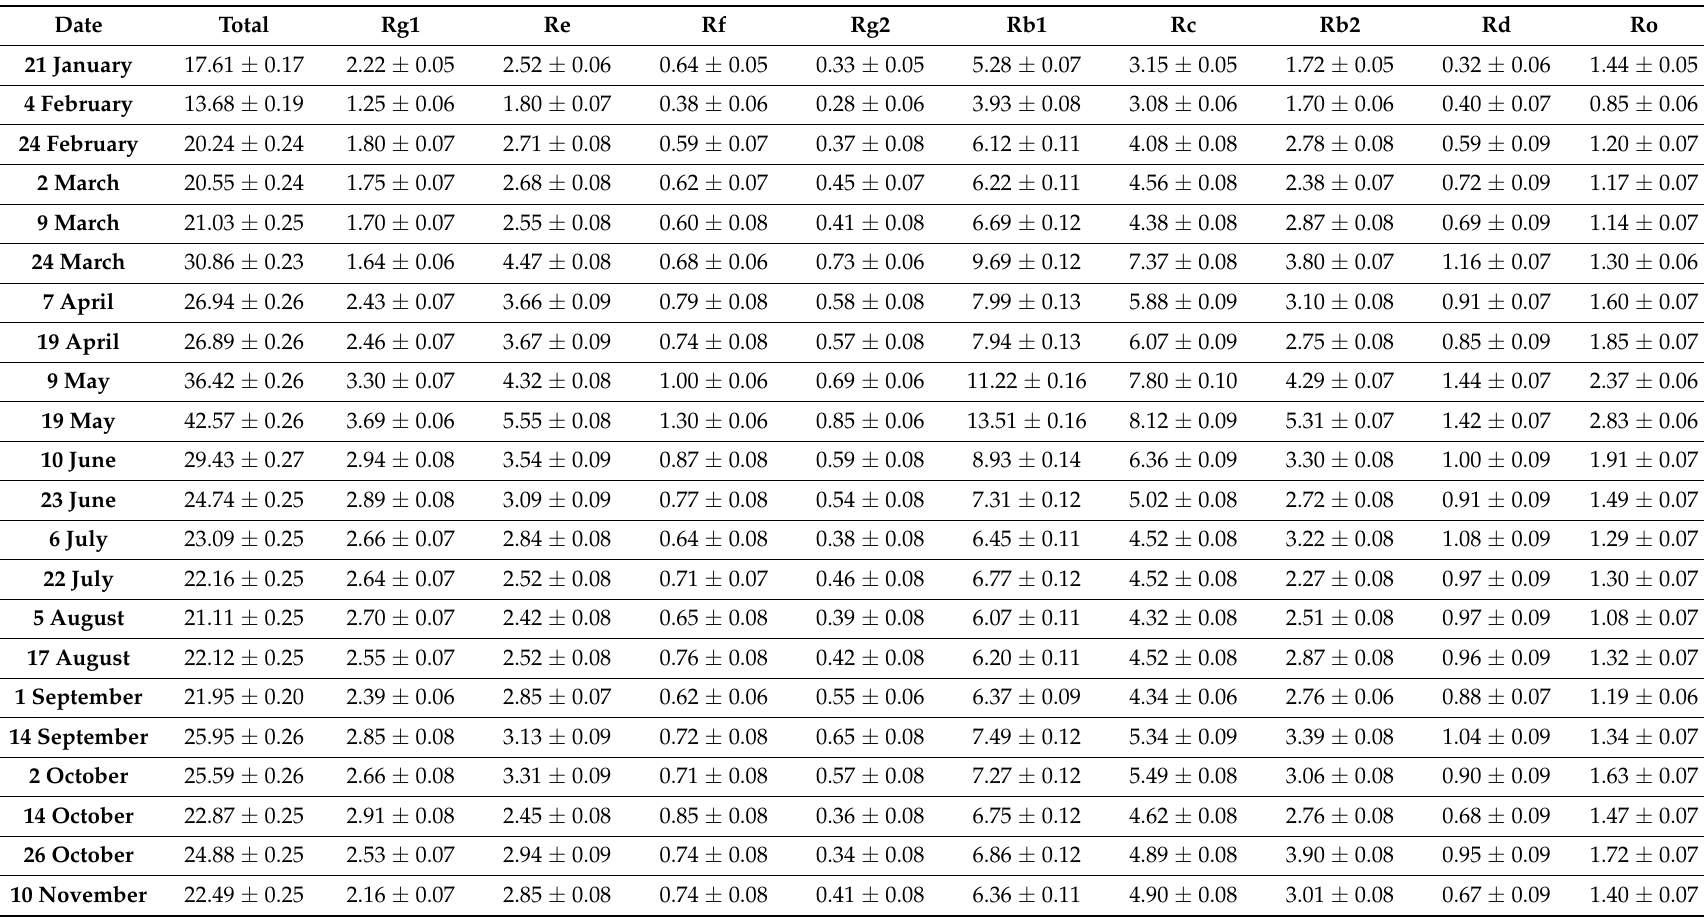
Table 2. Ginsenosides contents (mg/g) of P. ginseng grown at Bongwha, Korea in